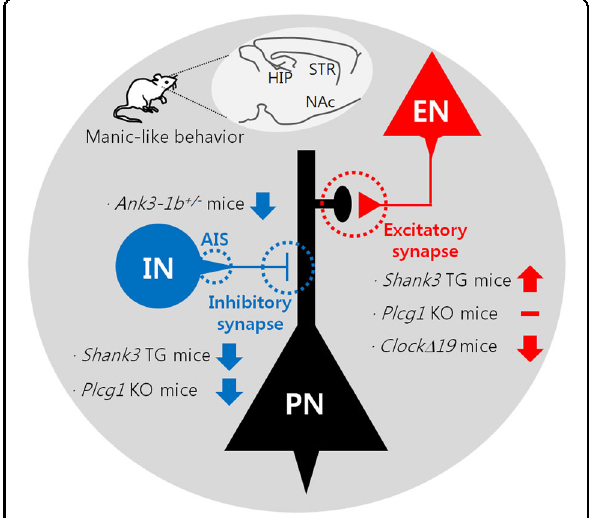
Fig. 1 Summary of the E/I synaptic dysfunction in animal models of mania. In the hippocampus of Shank3 TG mice, excitatory synaptic function is increased, while inhibitory synaptic function is decreased. In the hippocampus and striatum of forebrain-speci fi c Plcg1 KO mice, excitatory synaptic function is normal, but inhibitory synaptic function is decreased. In the NAc of Clock Δ 19 mutant mice, excitatory synaptic function is decreased. In the brain regions of Ank3-1b + / − mice, function of the AIS of the PV-positive interneuron is impaired. EN excitatory neuron, HIP hippocampus, IN inhibitory neuron, PN principal neuron, STR